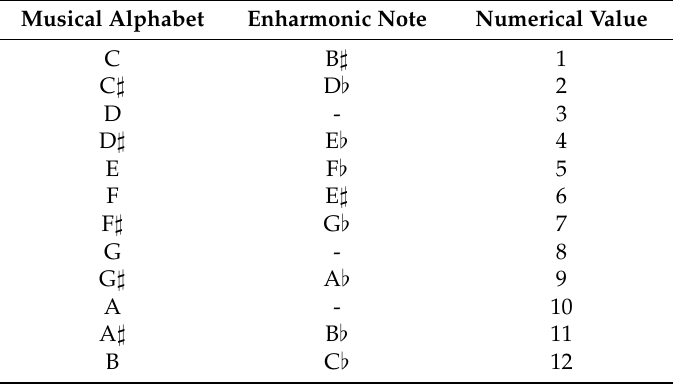
Table 2. The sample of numerical value for musical alphabet.